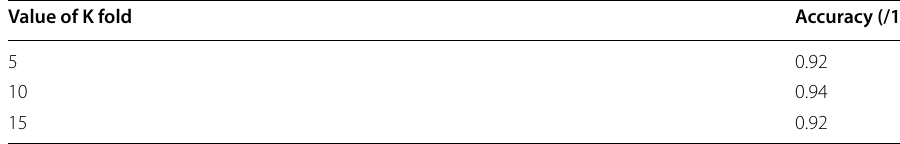
Table 4 ANN model accuracy result